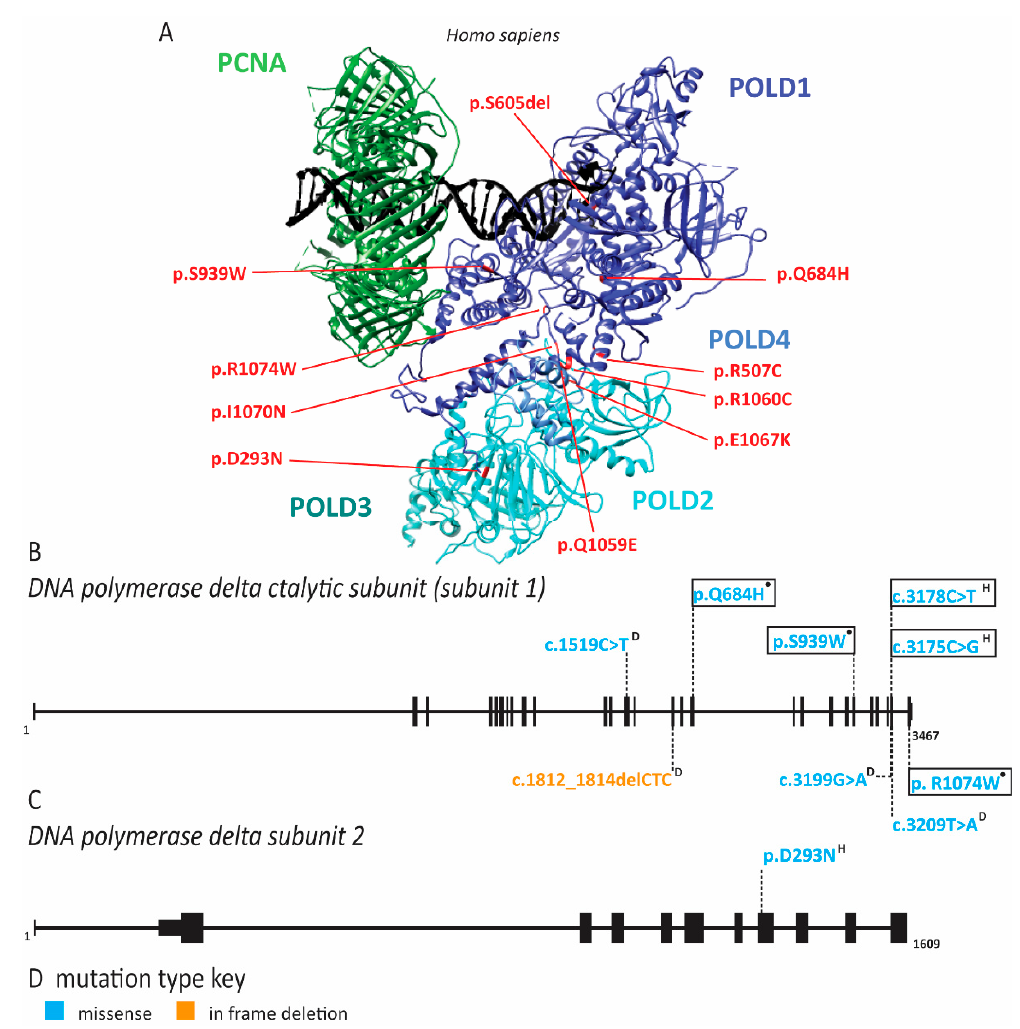
Figure 10. Pathogenic variants in pol δ subunits cause human disease. Pathogenic mutations in pol δ subunits are depicted on a schematic of each gene and the crystal structure of Homo sapiens pol δ complex. Mutations that do not have corresponding amino acids in the structure or resulted in abnormal splicing are not depicted. For a complete list of mutations and associated protein changes, see Supplementary Table S1. Structures were generated with the Chimera program (http://www.cgl.ucsf.edu/chimera). Exon and intron schematics were generated with the UCSD genome browser. Reference sequences are POLD1 NM_001256849.1 and POLD2 NM_006230.4. ( A ) Crystal structure of human pol δ subunits with mutations depicted including missense and nonsense mutations depicted in red and frame shift mutations depicted in orange. The structure was generated using pdb file 6s1m. Schematic of ( B ) POLD1 and ( C ) POLD2 genes depicted with exons as black boxes and introns as horizontal lines. Mutations are mapped to the appropriate gene regions. Boxed alleles on POLD1 occur in individuals with immune deficiency. Note that the black circle symbol indicates mutations found together in an individual, p.Q684H and p.S939W were found in cis while p.R1074W was found in trans. Compound heterozygous mutation pairs are indicated by superscript symbols. Each mutation combination is depicted, and certain alleles may be present in multiple combinations. The frequency of each allele in the affected population is not indicated. ( D ) For each gene, the color of the mutations indicates the type of mutation according to this key.